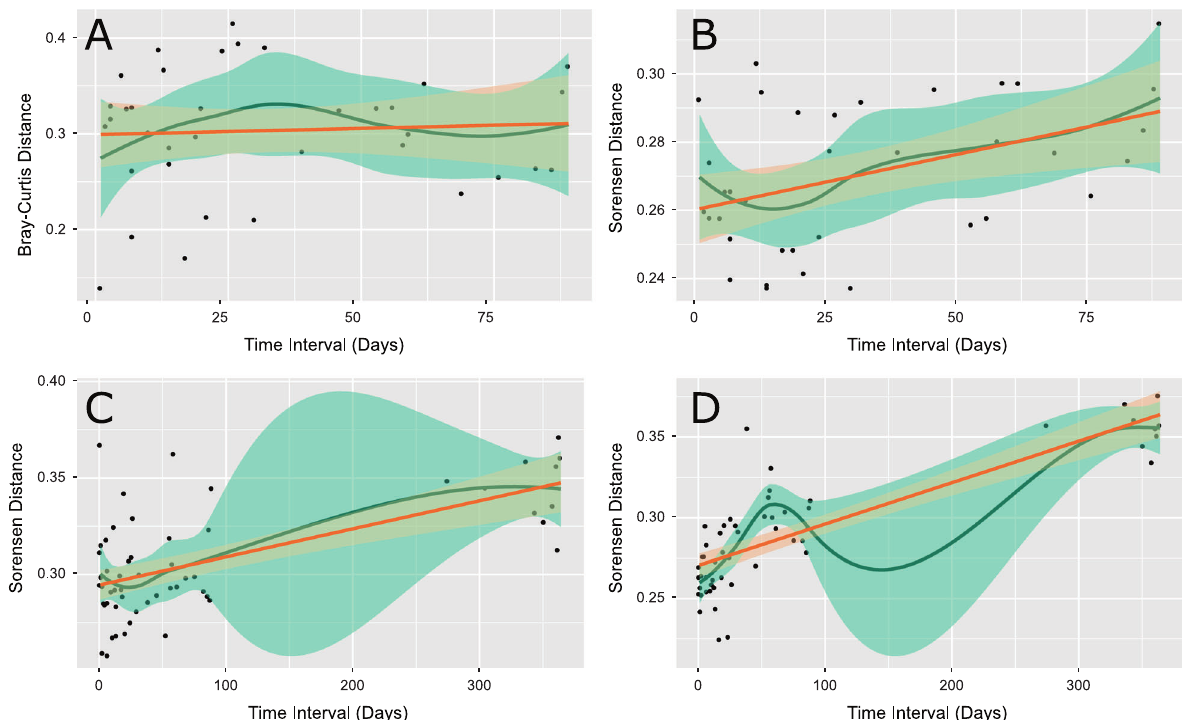
Fig. 4 Lag plots of beta-diversity measures between sample pairs against the time elapsed between sample dates. Yellow lines are the linear least squares regression fi ts with 95% con fi dence bands and blue lines are the Loess locally weighted regression curves with 95% con fi dence bands. a Bray – Curtis distances between saliva samples from subject 7. b Sorensen distances between saliva samples from subject 7. c Sorensen distances between saliva samples from subject 1. d Sorensen distances between saliva samples from subject